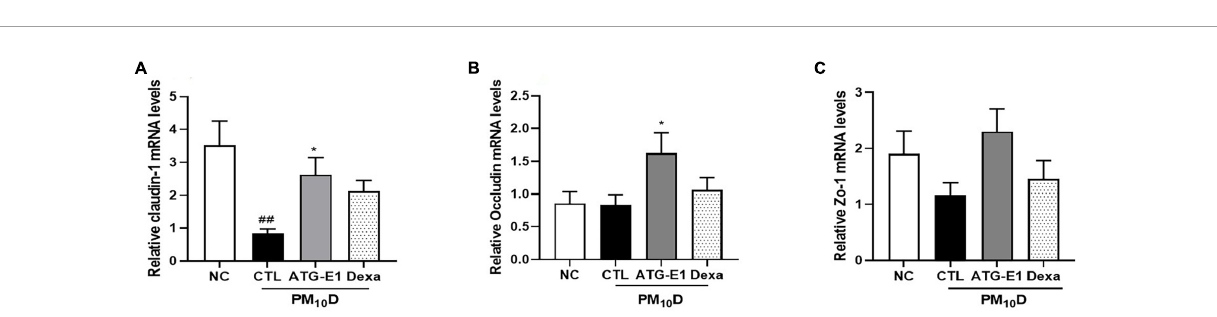
FIGURE6 Effects of L. paracasei ATG-E1 on the expression of tight junction-related genes in the ileum of a PM 10 D-induced airway inflammation animal. (A) Occludin, (B) claudin-1, and (C) ZO-1 mRNA expression levels in the ileum. The data are presented as means ± SEM ( n = 8). ## p < 0.01 vs. NC; * p < 0.05 vs. CTL. NC: normal mice; CTL: PM 10 D-sensitized control mice; Dexa: 3 mg/kg dexamethasone-treated PM 10 D-sensitized mice; ATG-E1: 4 × 10 9 CFU/day of L. paracasei ATG-E1-treated PM 10 D-sensitized